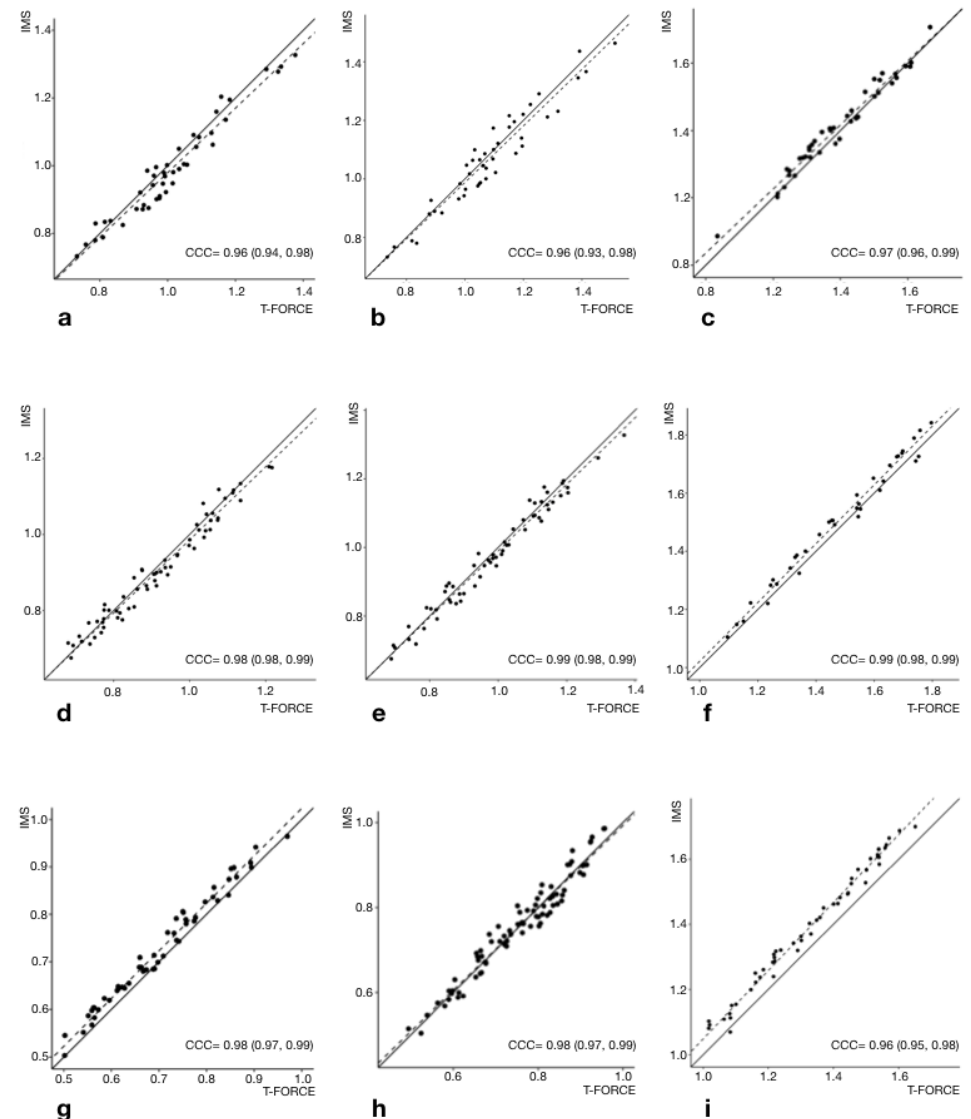
Figure 2. Lin’s concordance correlation coefficient (CCC) between the T -Force device ( X -axis) and the IMS sensor ( Y -axis) for mean velocity (MV: a, d, g), maximum velocity (Vmax: b, e, h) and mean propulsive velocity (MPV: c, f, i). MV — 0.02 kg·m 2 ( a ), MPV — 0.02 kg·m 2 ( b ), Vmax — 0.02 kg·m 2 ( c ), MV — 0.05 kg·m 2 ( d ), MPV — 0.05 kg·m 2 ( e ), Vmax — 0.05 kg·m 2 ( f ), MV — 0.11 kg·m 2 ( g ), MPV — 0.11